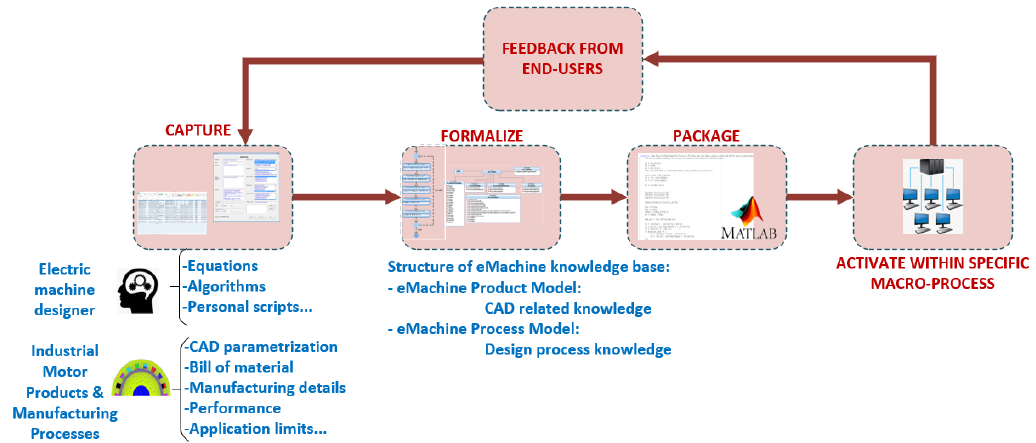
Figure 4. KBE system development process.